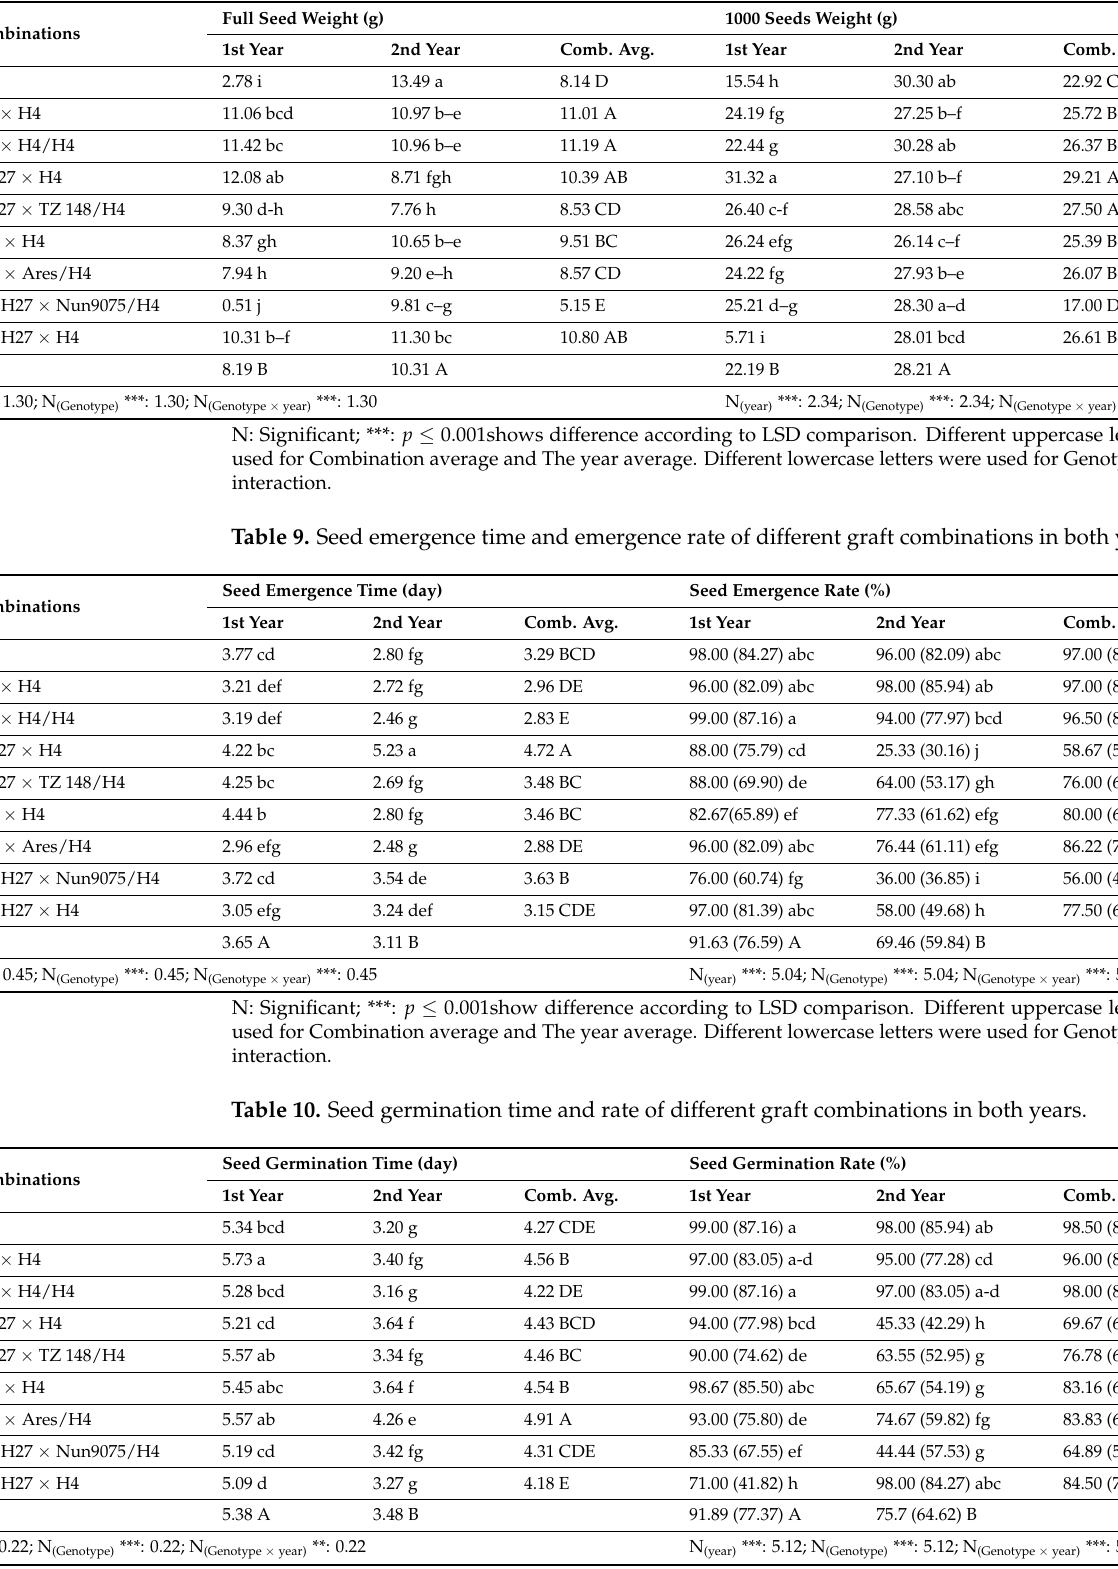
Table 8. Full seed weight and weight of 1000 seeds of different graft combinations in both years.